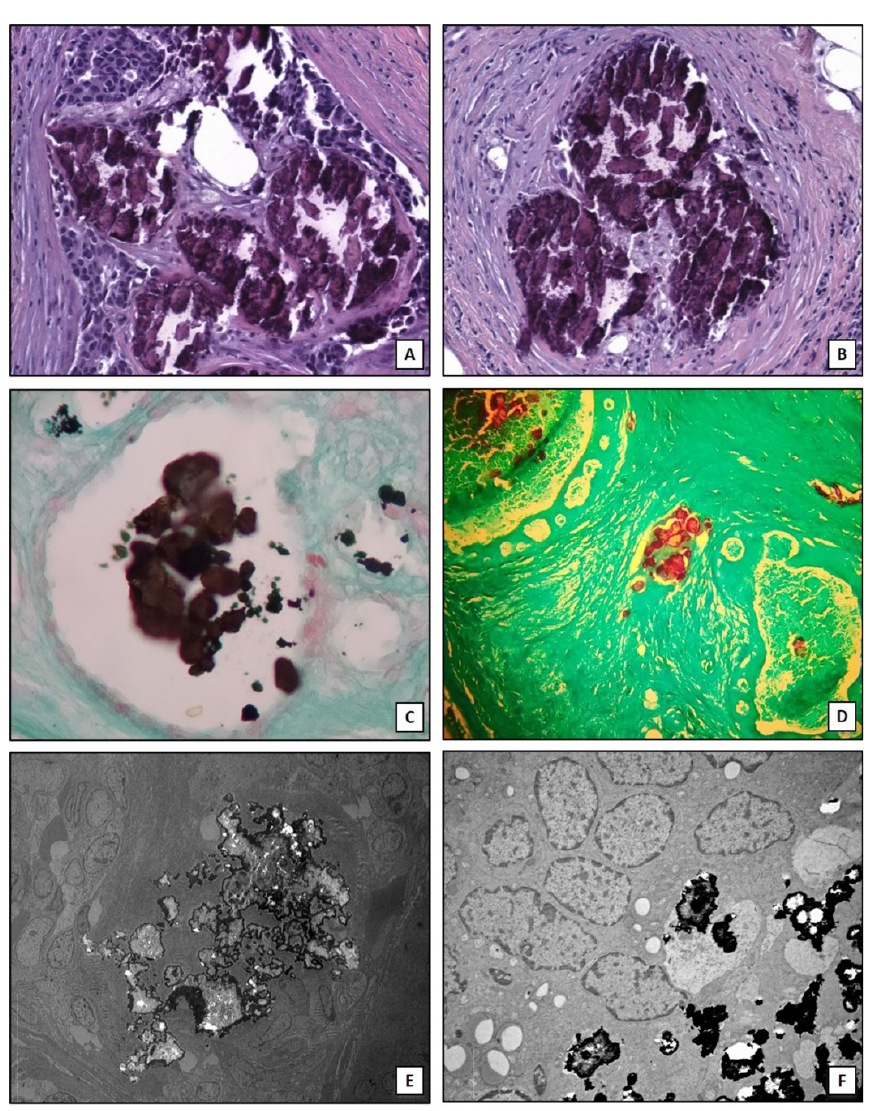
Figure 2. Breast microcalcifications. ( A ) Hematoxylin and eosin section shows dystrophic calcifica- tions embedded into an infiltrating breast carcinoma (10 × ). ( B ) Dystrophic calcifications in breast a benign lesion (10 × ). ( C ) Traditional von Kossa staining shows calcium crystals (black) into a breast normal duct (10 × ). ( D ) TorVergata modified von Kossa staining displays calcium deposits (red) into breast ducts and stroma (5 × ). ( E ) Electron micrograph shows electrondense large calcification in an infiltrating breast carcinoma (2000 × ). ( F ) Small calcium crystals in an infiltrating breast carcinoma (5000 ×